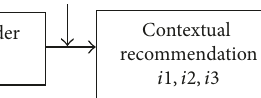
Figure 2: Prefiltering